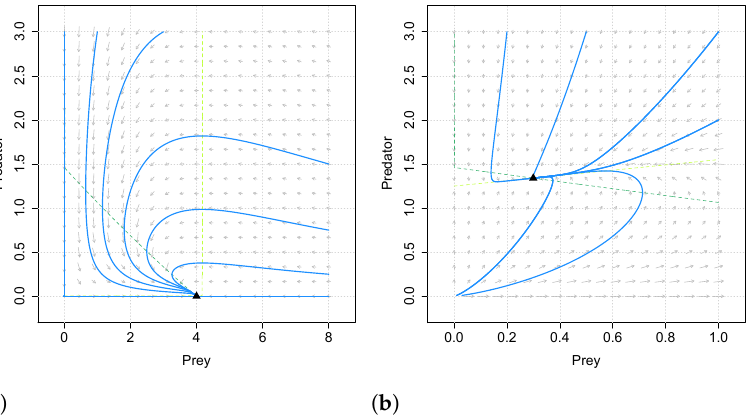
Figure 7. Dynamic behaviors with r = 1.6, s = 0.2, d = 0.8, a = 0.2, p = 0.3, c = 0.8, d 1 = 0.8 and n = 1. ( a ) Extinction of predators in system (19). ( b ) Coexistence in system